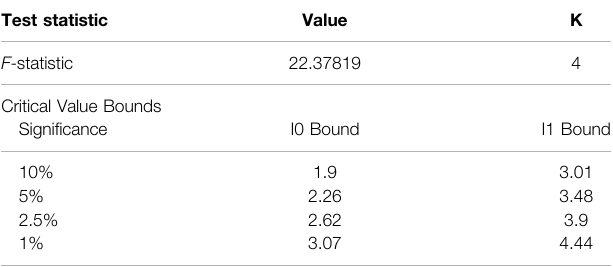
TABLE 4 | Long-run estimations.